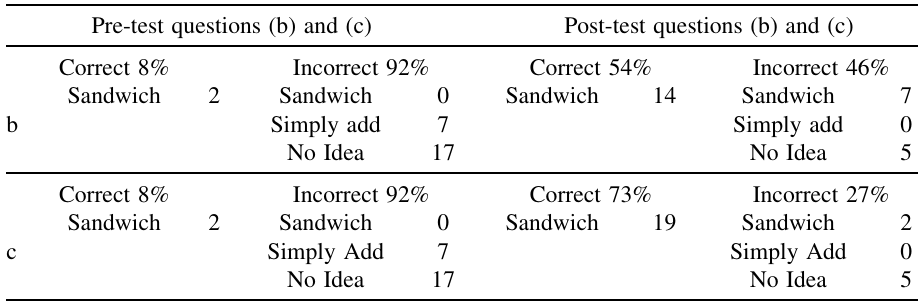
TABLE II. Correctness percentages of 26 students answering questions (b) and (c) in the pre- test and post-test. The item ‘‘sandwich’’ means that the students calculated the matrix elements by sandwiching the operator with the basis vectors. The item ‘‘simply add’’ represents the mistake of calculating the matrices by simply adding the matrices for the spin operators in different subspaces as though they were in the same vector space. The number corresponding to each item stands for the number of students giving a particular type of